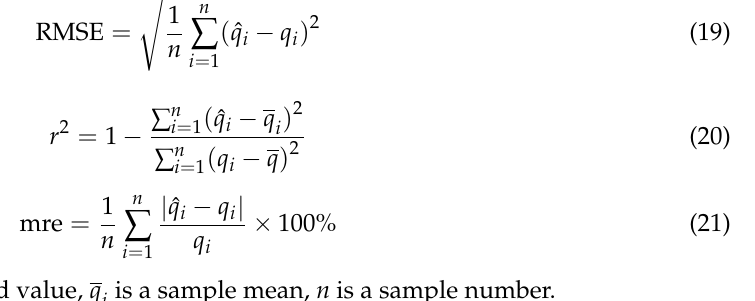
15 of 25 Figure 5. The predicted results of the test sets: ( a ) the predicted results of IMF1; ( b ) the predicted